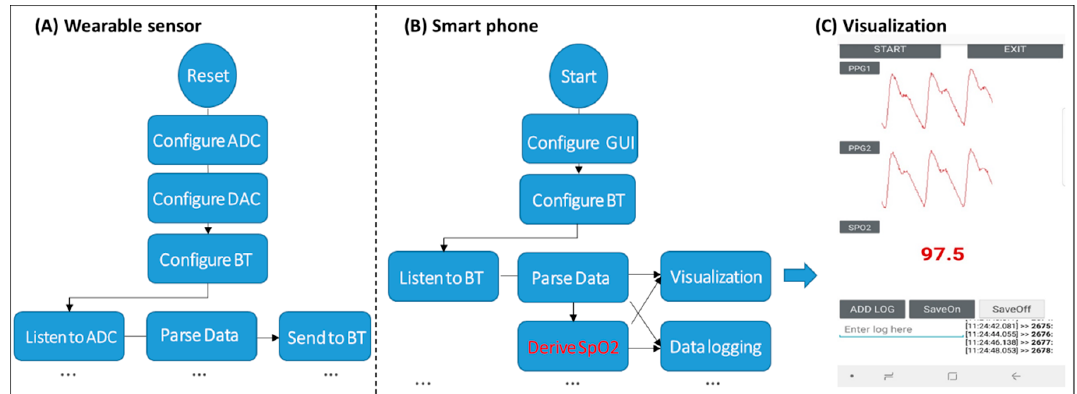
Figure 2. The mobile oxygen saturation (SpO 2 ) system that includes a wearable sensor for 2-channel photoplethysmogram (PPG) signal sensing and a smartphone application (APP) for data analysis and visualization. The sensor leverages a digital-to-analog converter (DAC) and an analog-to-digital converter (ADC) to emit light to and sense residual light (PPG signals) from the skin. The smartphone app configures the graphical-user-interface (GUI) and Bluetooth (BT) module to receive the data from the sensor and analyze the data. ( A ) Wearable sensor, ( B ) Smart phone, ( C ) Visualization.